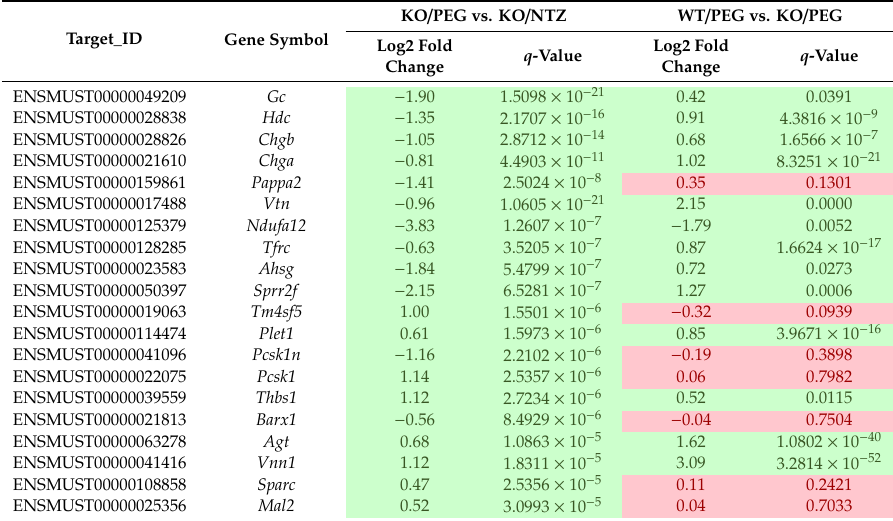
Figure 6. Global gene expression analysis of KO and WT mice given NTZ or PEG illustrated by at principal component analysis plot. Genotype a ff ects global gene expression more than NTZ. Table 4. Global gene expression analysis in KO / PEG versus KO / NTZ and KO / PEG versus WT / PEG mice illustrating the e ff ect of NTZ in KO mice. Di ff erentially expressed genes in the gastric corpus mucosa of KO / NTZ mice in comparison with KO / PEG mice sorted by ascending adjusted p -value ( q -value). Green: significant change (adjusted p -value ( q -value) < 0.05); red: non-significant change ( q -value >